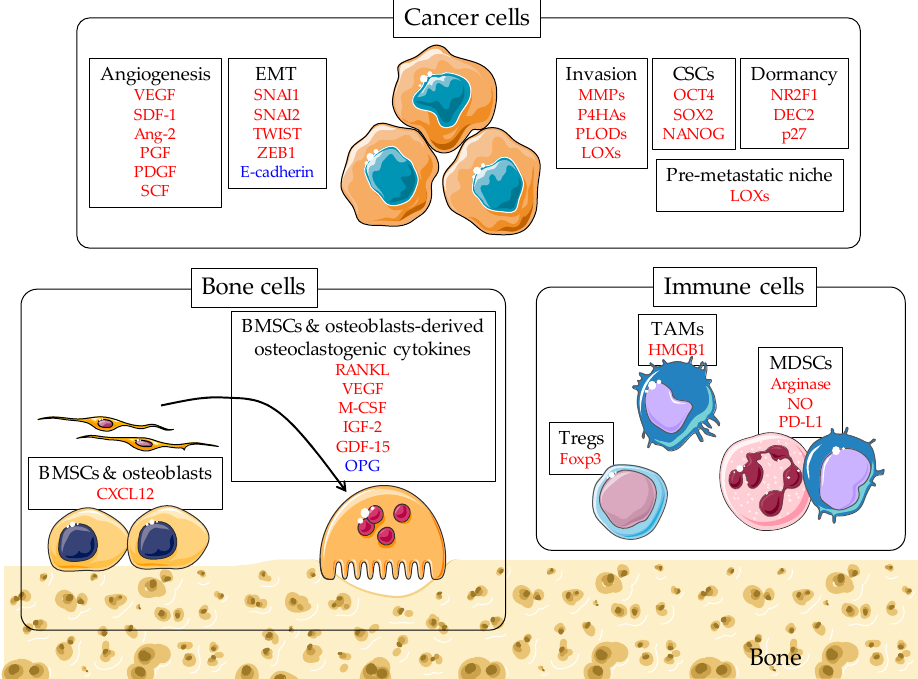
Figure 1. Hypoxic signaling in the bone-metastatic cascade. The figure summarizes hypoxia-induced and hypoxia inducible factor (HIF)-target genes involved in the key stages of the bone-metastatic cascade. Upregulated genes are shown in red and downregulated genes are in blue. Images adapted from Servier Medical Art (https://smart.servier.com/).